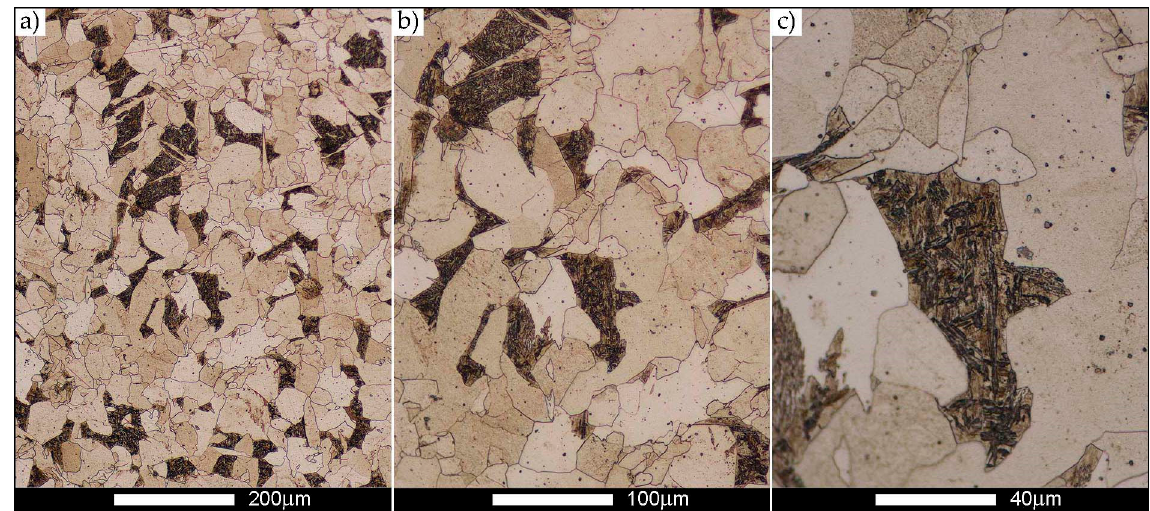
Figure 34. Welded joint microstructure of Hardox 450 steel with visible grain boundaries of prior austenite, austenitised at 1200 °C—WM1 zone shown in Figure 2. ( a ) 100×; ( b ) 200×; ( c ) 500×.